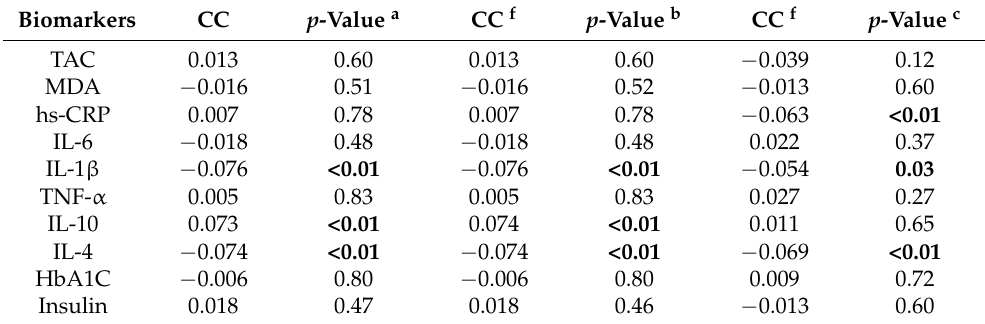
Table 3. Pearson and partial correlation coefficients between HEI and serum levels of inflammatory and antioxidant biomarkers ( n =